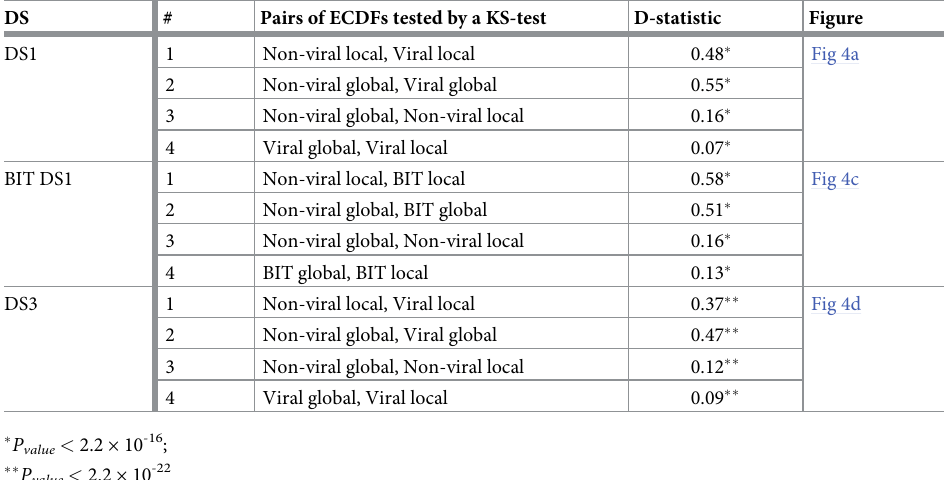
Table 6. Kolmogorov-Smirnov results.